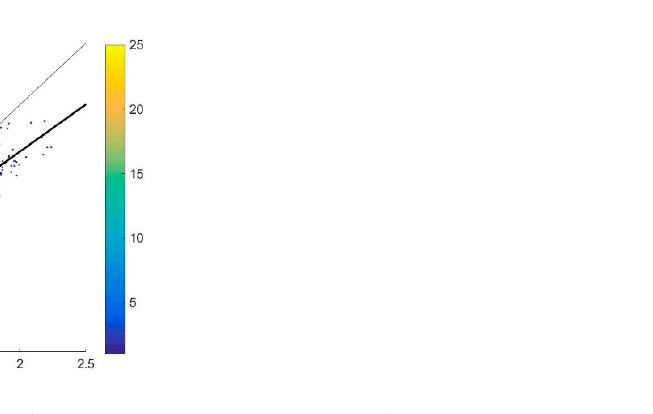
Figure 19. AOD maps over Eastern Asia on 24 September 2009: ( a ) NP AVHRR AOD; ( b ) AQUA MODIS Dark Target and Deep Blue AOD product; ( c ) RGB composite image of MYD02 data with a spatial resolution of 1 km.